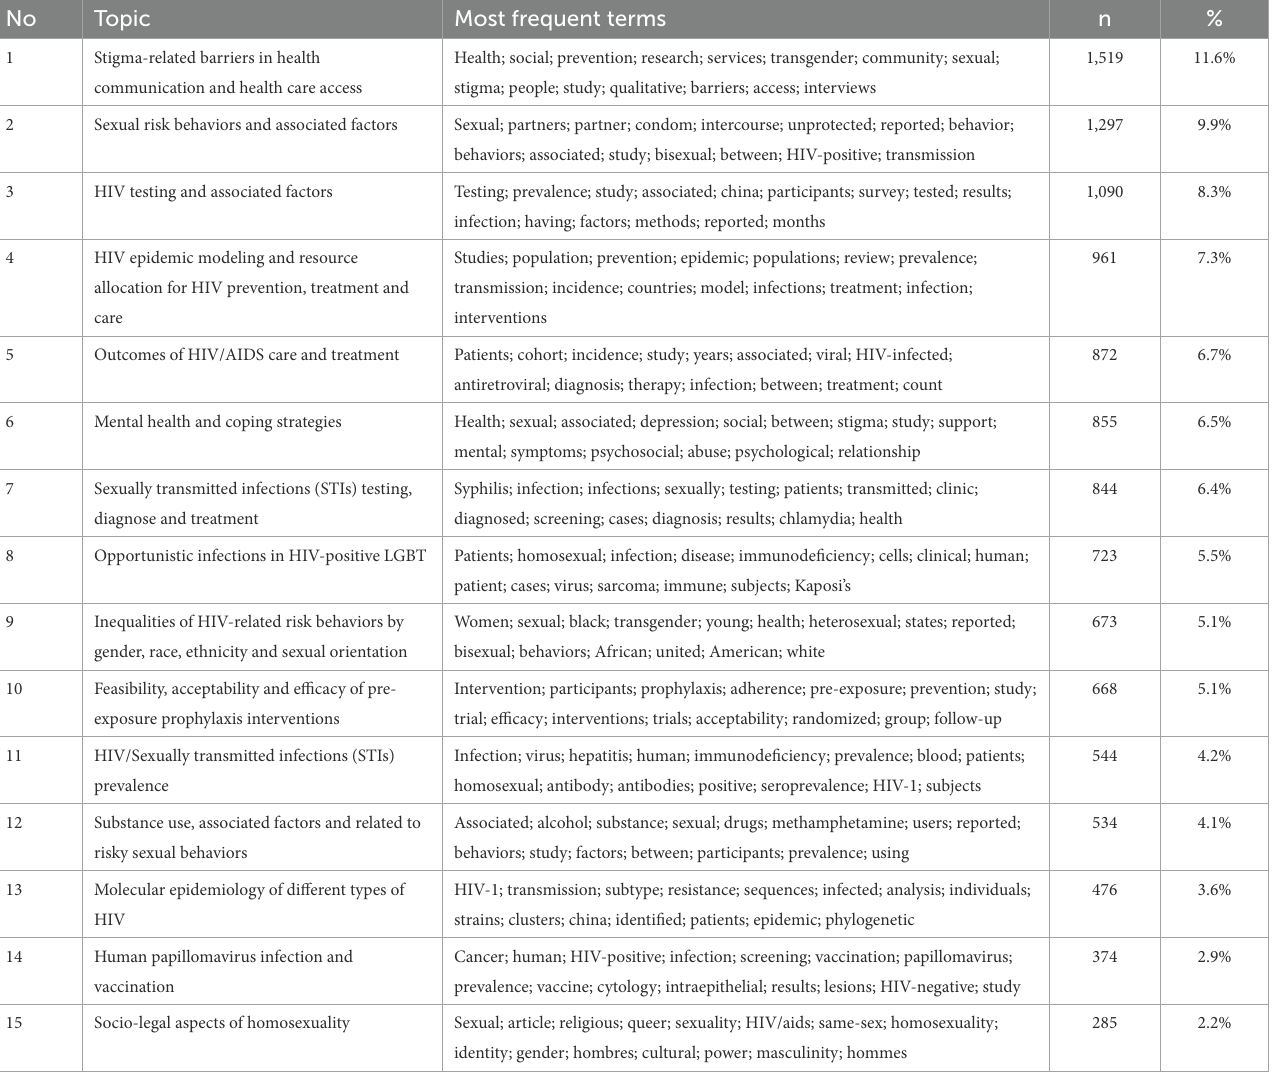
TABLE 3 Fifteen topics classified by LDA and 15 most frequent terms in each